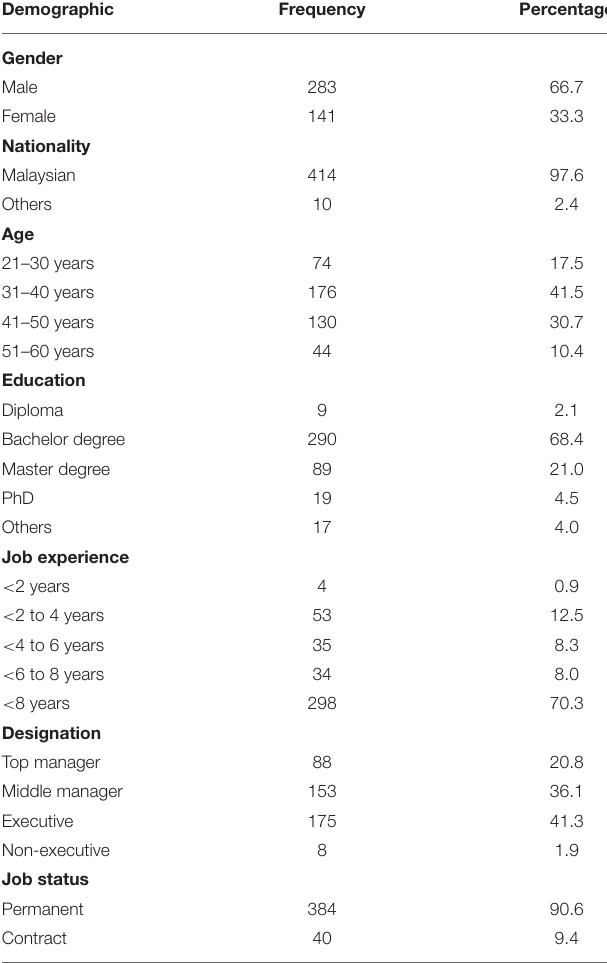
TABLE 1 | Respondent’s demographic